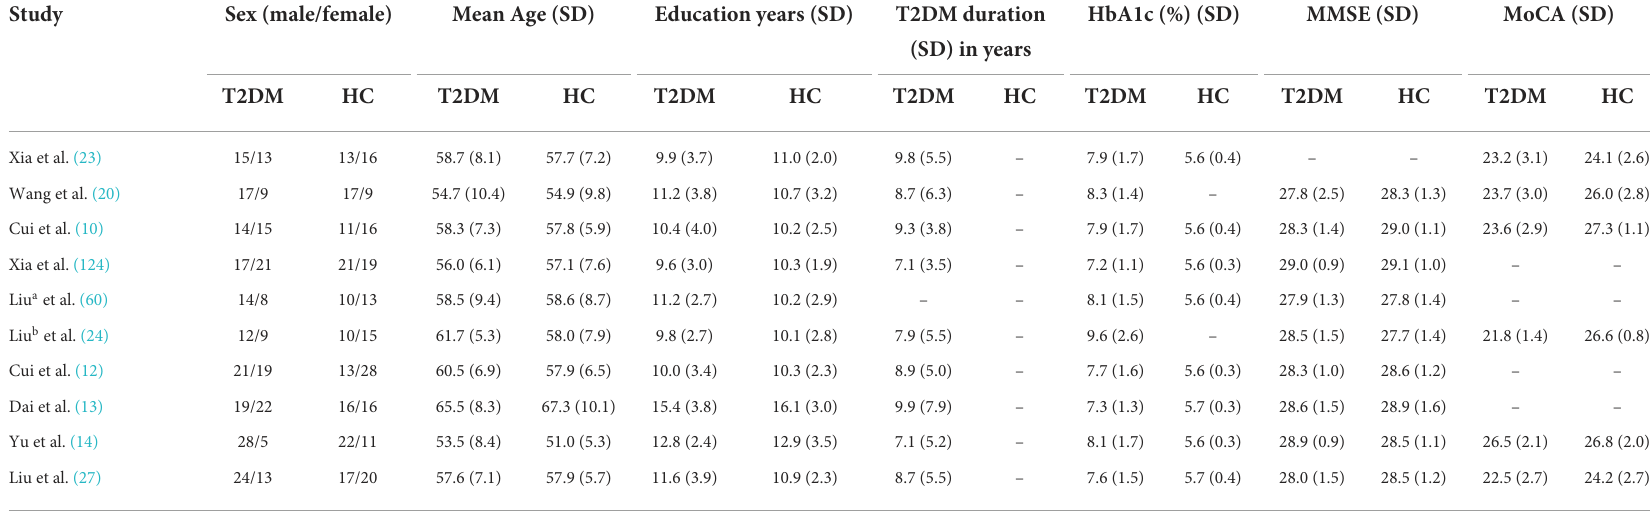
TABLE 3 Demographic, clinical, and cognitive characteristics of study patients and control subjects included in the meta-analysis (group 2).